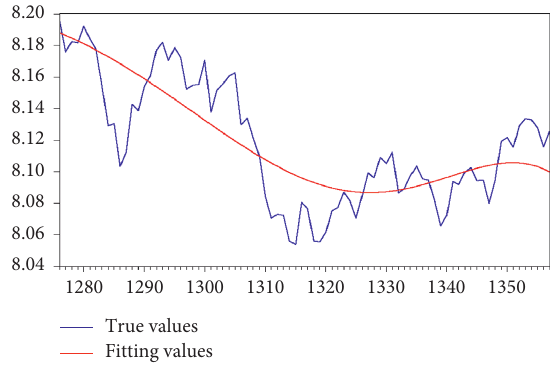
Figure 15: Fitting results from 2010/7 to 2010/10.